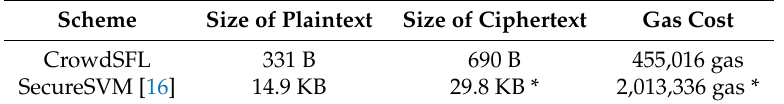
Table 2. Comparison of communication overhead between CrowdSFL and SecureSVM